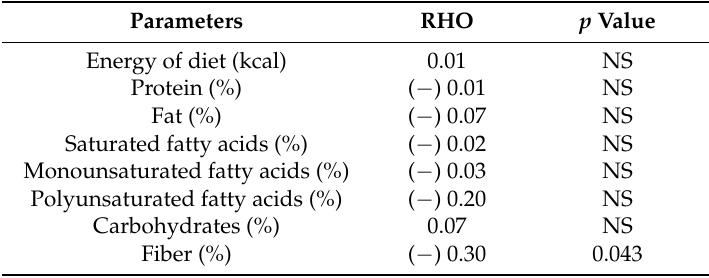
Table 5. Correlations between diet compounds and the concentration of serum